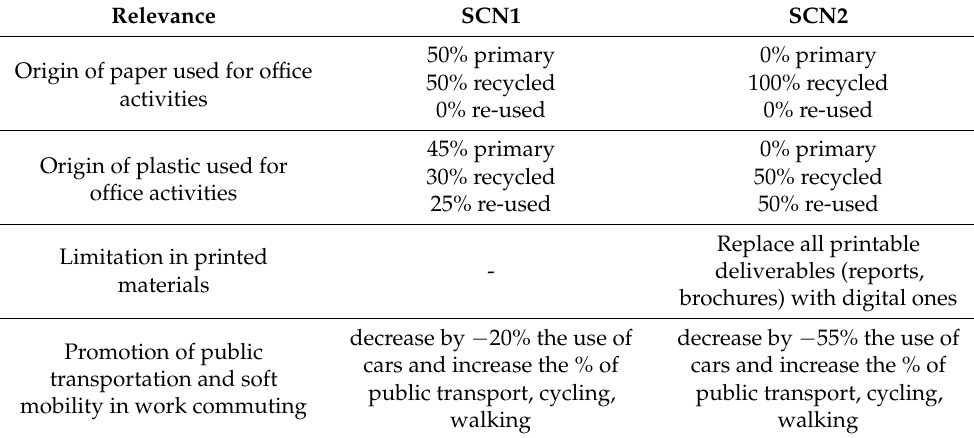
Table 1. Description of the mitigation scenarios related to office activities and employees for reducing the CF of the research